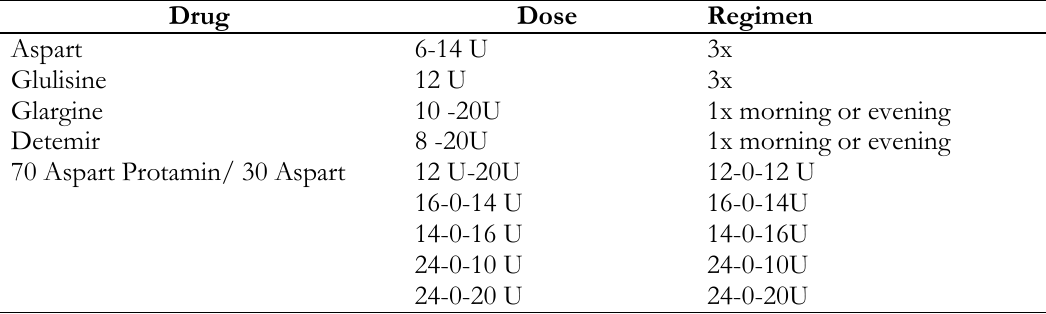
Table IV. Dose and regimen of subcutan insulin in geriatric outpatients Dr. Soetomo